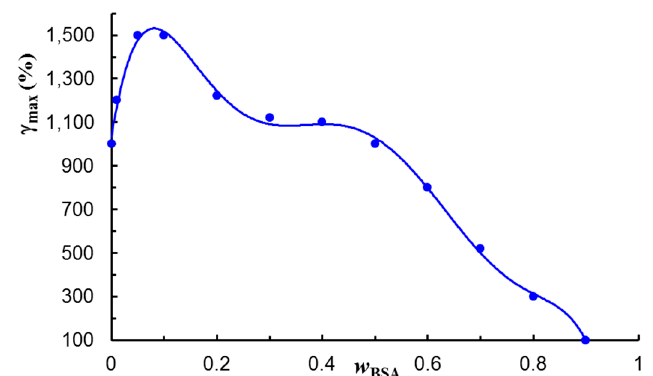
Figure 8. The maximum deformation value supported by PVA/HPC/BSA hydrogels of different BSA content, before the failure of their structure [24]. Adapted with permission from Ref. [24]. Copyright 2022, MDPI.